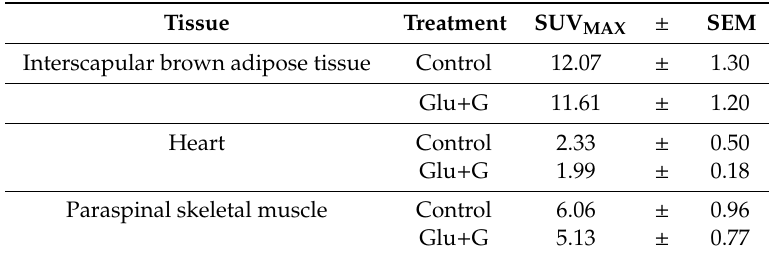
Table 2. Glucose uptake following glutamic acid (Glu) and glucose (G) injection.